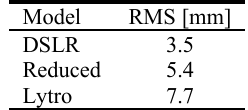
Table 2. Root mean square for the photogrammetric models matched to the laser scan model using eight tie points.